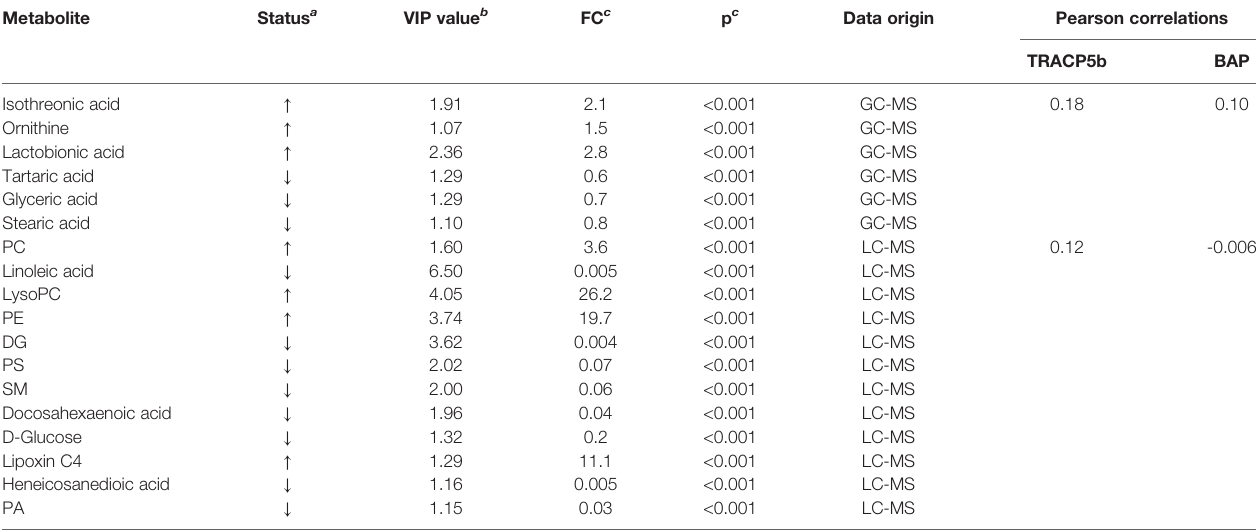
TABLE 2 | Summary of potential biomarkers of the case group by serum GC/LC-MS